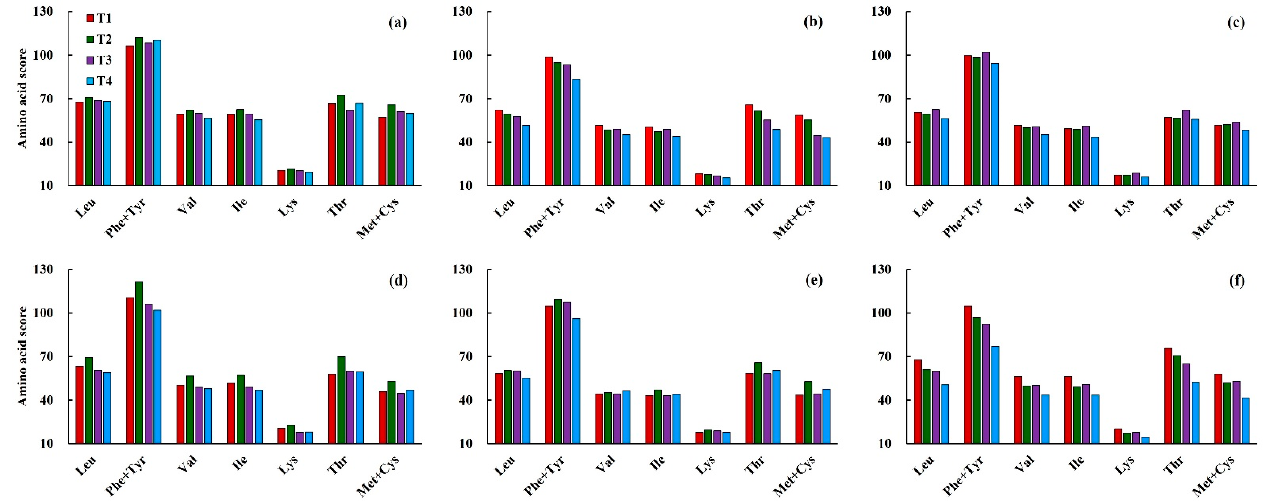
Figure 6. Effects of different low-temperature intensities and stages on the amino acid score of Yangmai16 ( a – c ) and Xumai30 ( d – f ). ( a , d ) jointing stage; ( b , e ) booting stage; ( c , f ) jointing and booting stages.